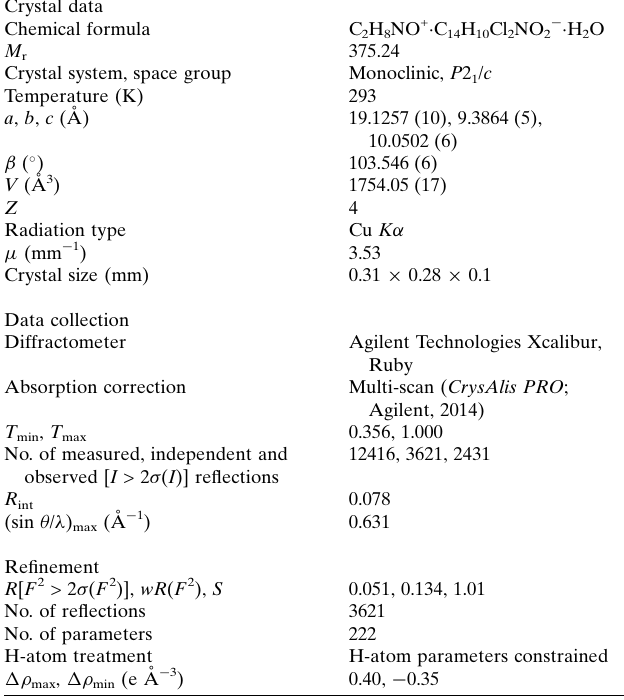
Crystal data Chemical